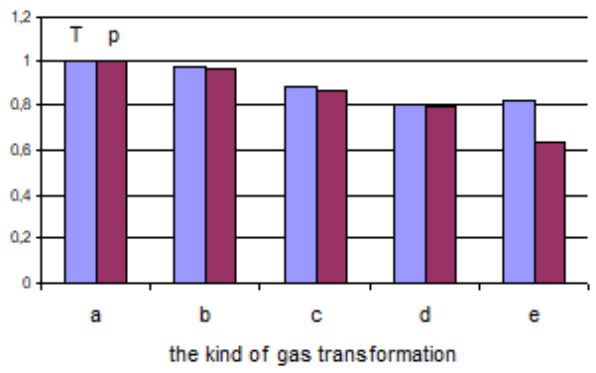
Fig. 3. The quotient values of temperature and pressure for different types of air change in comparison to adiabatic process at piston location in TDC